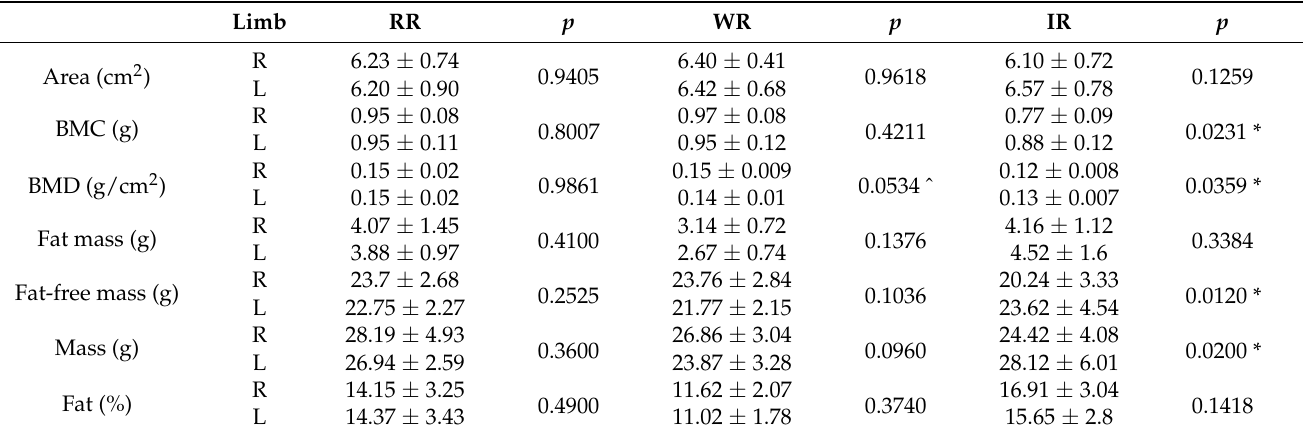
mass compared with the WR and IR groups: RR vs. WR p = 0.0017, RR vs. IR p = 0.0.0211 (Figure 2d), RR vs. WR p = 0.0189, RR vs. IR p = 0.0107 (Figure 2e). 2.3. Impact of Physical Activity on the Musculoskeletal System—Limb and Knee Parameters The comparison of the results obtained for the hind limbs and knee joints with MIA induced OA (right side) and for control (left side) are shown in Tables 1 and 2, respectively. Table 1. Comparison of the parameters of both hind limbs of the animals (right R vs. left L).